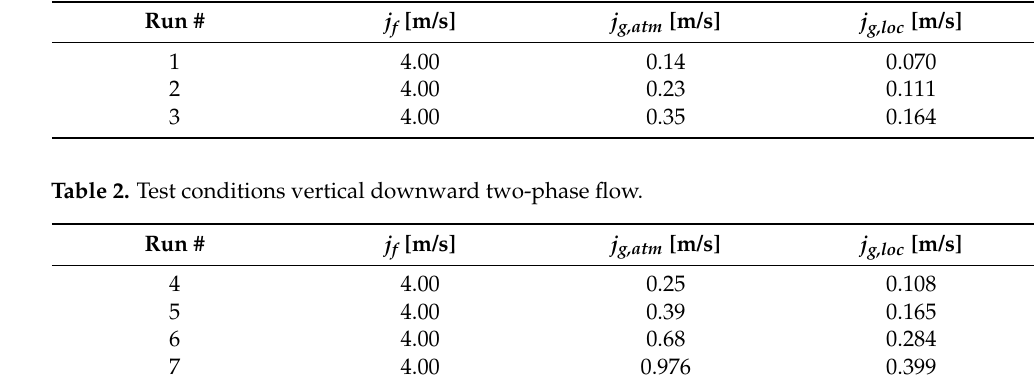
Table 1. Test conditions vertical upward two-phase flow.